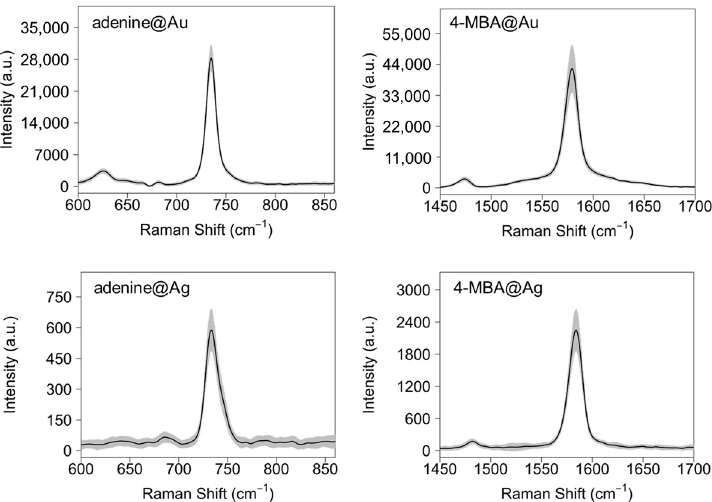
Figure 3. Mean SERS spectra of the most intense bands of adenine and 4-mercaptobenzoic acid (4-MBA) acquired on Au and Ag substrates, calculated from maps consisting of 64 (i.e., 8 × 8) spectra acquired at 785 nm for the Au substrates and at 514.5 nm for the Ag substrates. Shaded areas represent ±1 intensity standard deviation